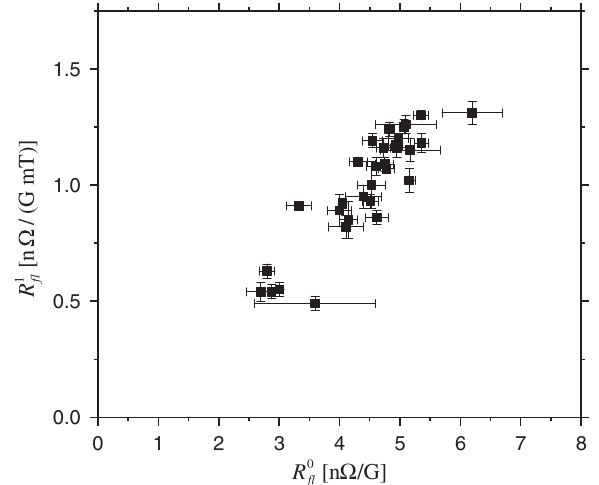
FIG. 3. Correlation plot of R o 1500 MHz [6].